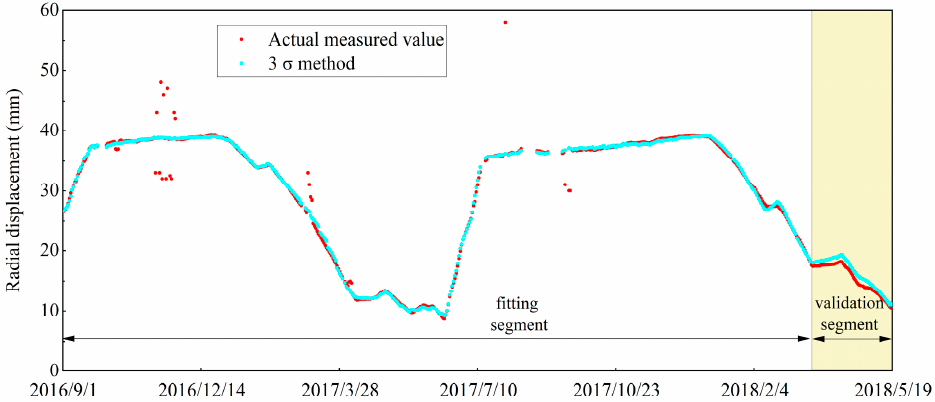
Figure 9. Dam monitoring model after eliminating gross errors by the Romanovsky criterion.